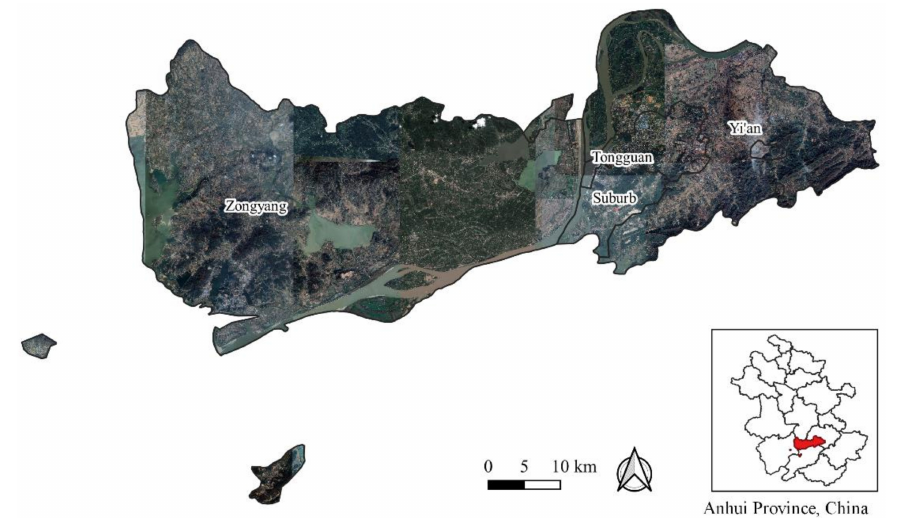
Figure 3. Study area: Tongling city, Anhui